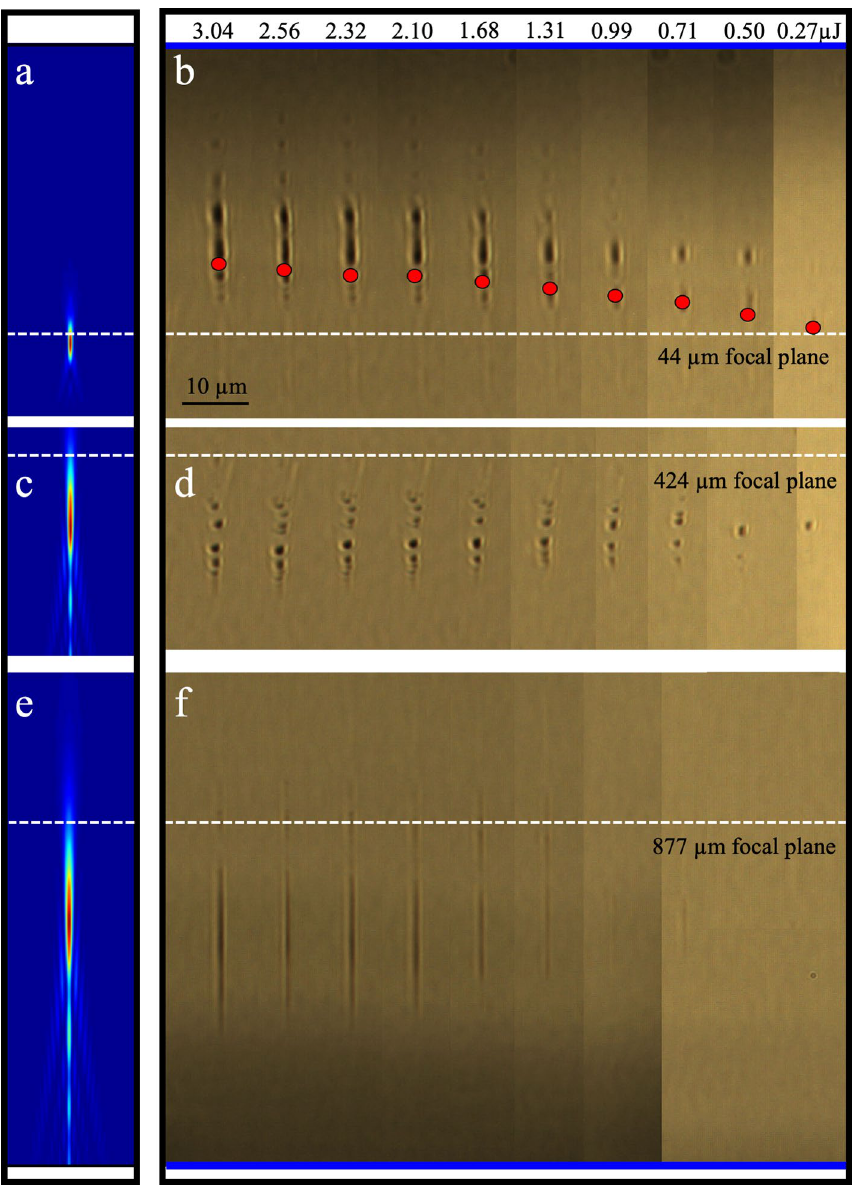
Figure 2. Laser modification of fused silica as distorted by Kerr lensing, plasma defocussing and surface aberration. Simulated longitudinal profile of focussed Gaussian beam under surface aberration for focussing depths of 44 µm ( a ), 424 µm ( c ), and 877 µm ( e ), and the corresponding optical microscope images ( b , d , and f ) at similar respective depths, of laser modification tracks observed under backlighting. Interaction of single laser pulses of varying energy (0.27 to 3.04 µJ) were distorted by Kerr self-focussing ( b ), plasma defocussing ( d ) and surface-aberration elongation ( f ) relative to the paraxial focal plane (white dashed line). The surface aberration simulation indicates stretching of the DOF from DOF(0,0) = 2.6 µm (without aberration) to ~ 4, 13, and 32 µm for the respective deeper focal depths. The top and bottom surfaces of the 1 mm thick substrate are marked by blue lines in ( b , f ), respectively. The scale bar of 10 µm applies to all